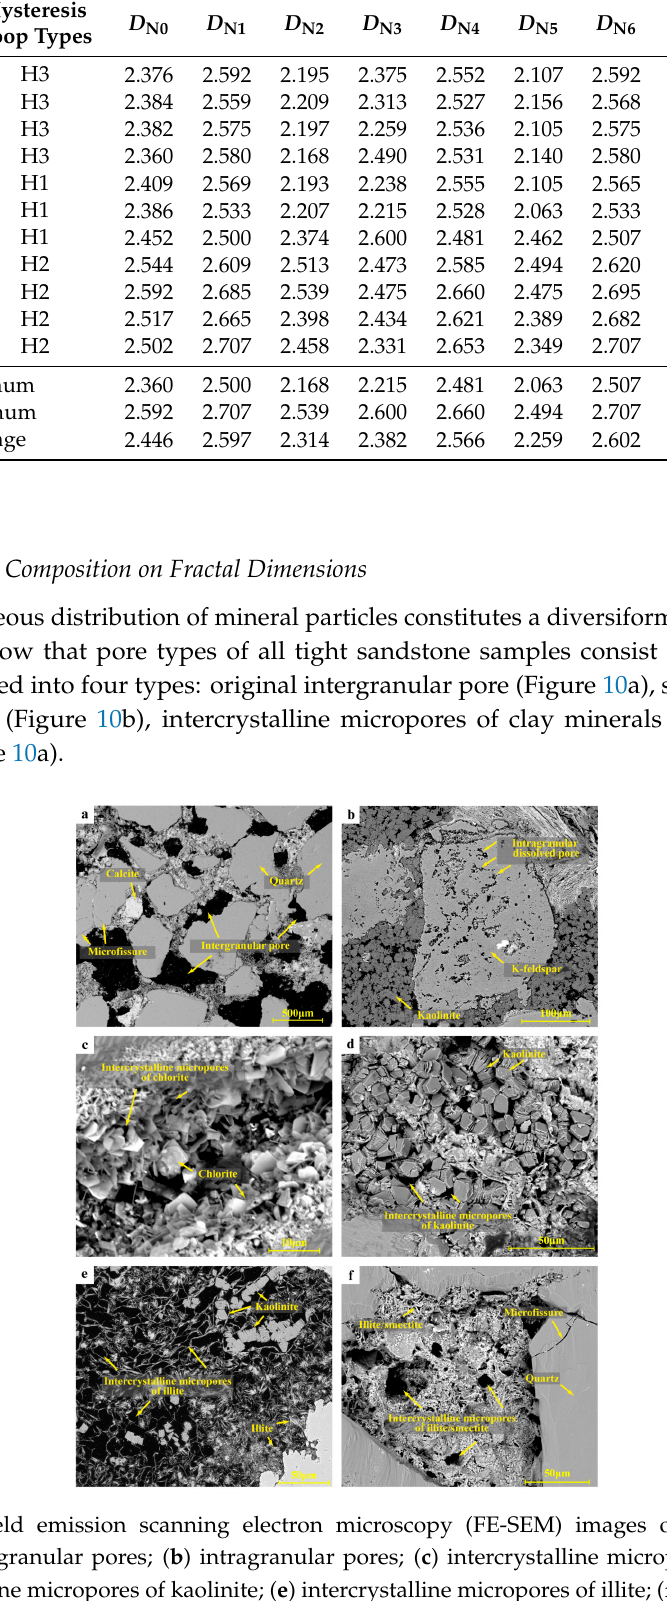
Table 4. Fractal dimensions from N 2 adsorption data of different class He 8 Member tight sandstone samples.